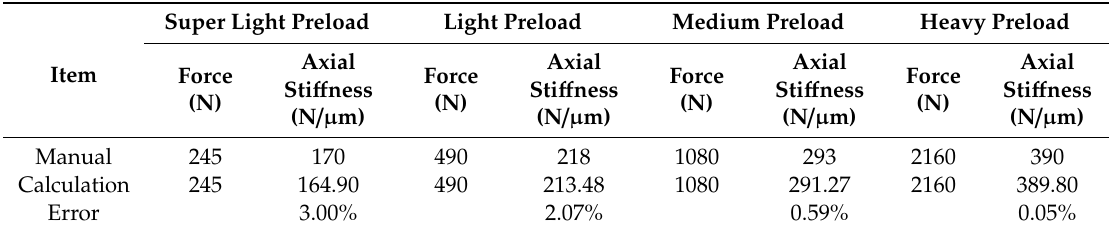
Table 1. The bearing sti ff ness comparison between the numerical calculation results and the NSK manual.